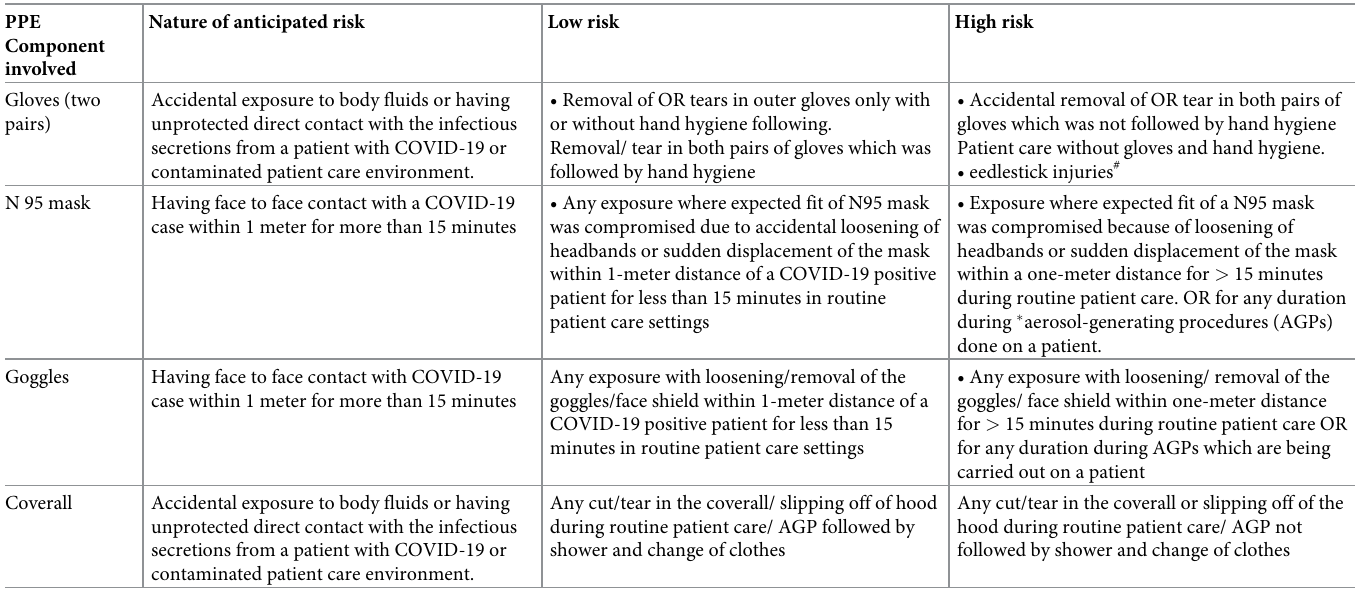
Table 1. Risk categorization of PPE breaches according to PPE